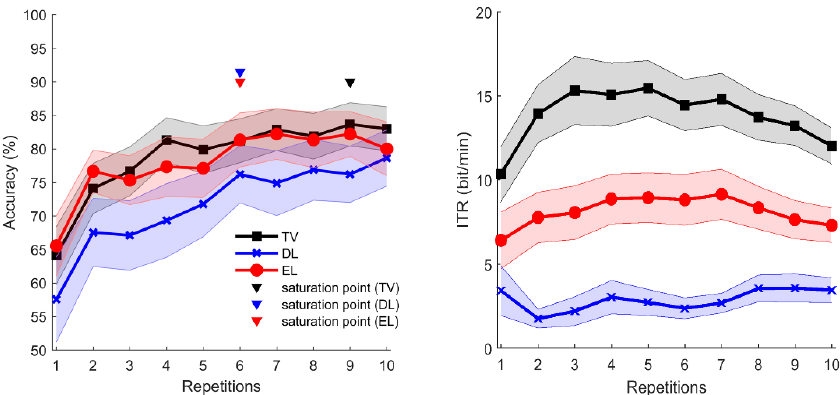
Figure 5. Performance changes depending on the number of stimulation repetitions. ( Left panel ) Shows the curves of classification accuracy of each type of BCIs. ( Right panel ) shows those of the information transfer rate (ITR).